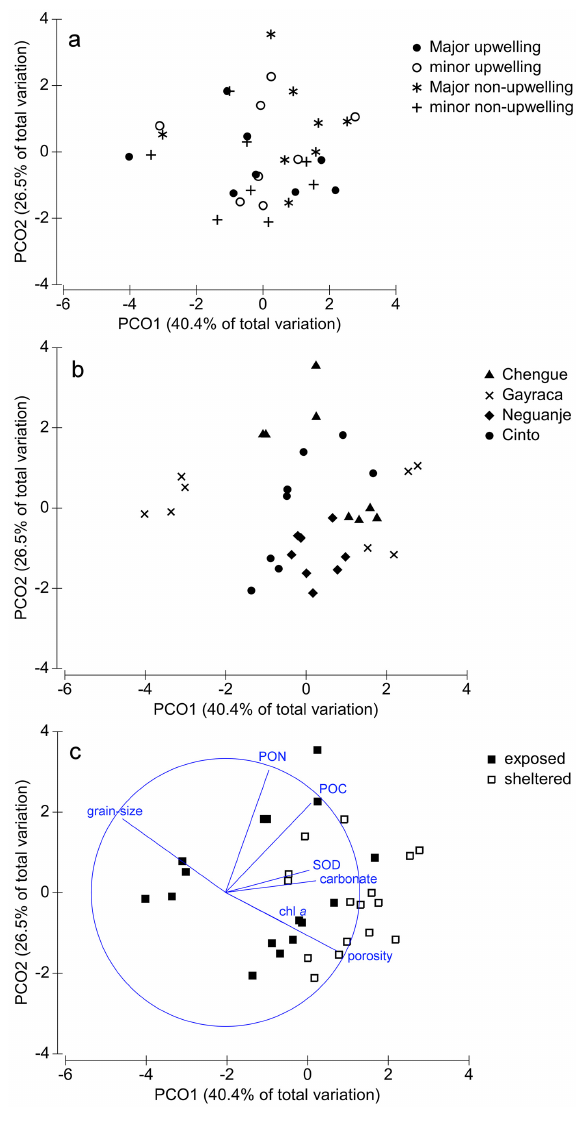
Figure 5. Graphical representation of multivariate analyses results by principle coordinates ordination (PCO). PCO of environmen- tal sedimentary parameters was grouped by seasons (a) , bays (b) , and exposure to wave and water currents of the sampling locations (c) . Effects and directions of environmental variables in (c) are dis- played as vectors with the abbreviations particulate organic carbon (POC), particulate organic nitrogen (PON), chlorophyll a (chl a ) and sediment oxygen demand